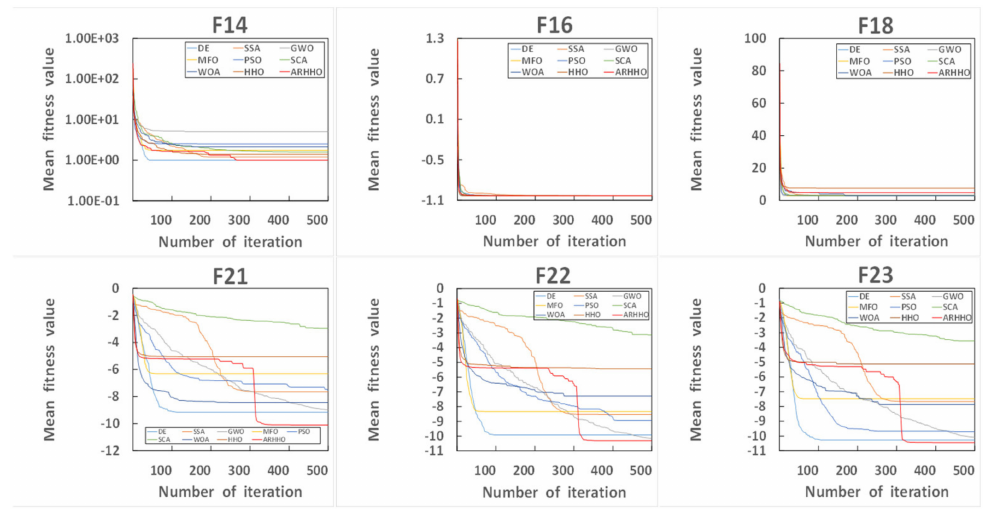
Figure 7. Convergence curves of fixed-dimensional